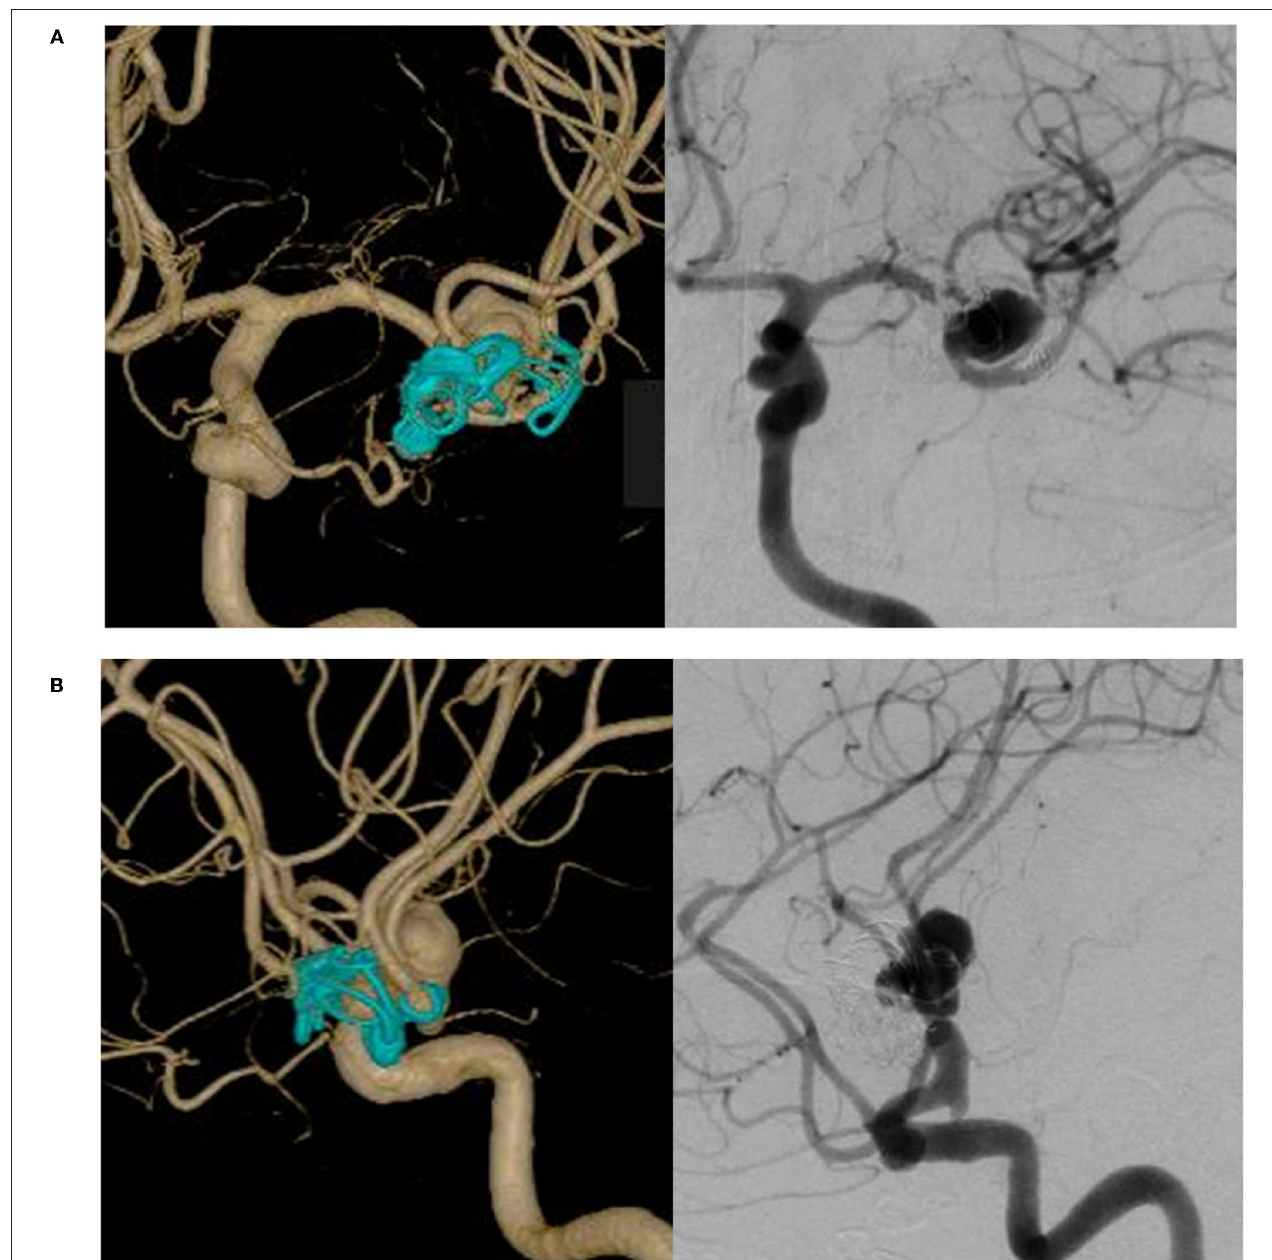
FIGURE 1 | Left internal carotid angiography reveals recurrent large middle cerebral artery aneurysm unrelated to a previous coil. (A) In an antero-posterior view. (B) In a lateral